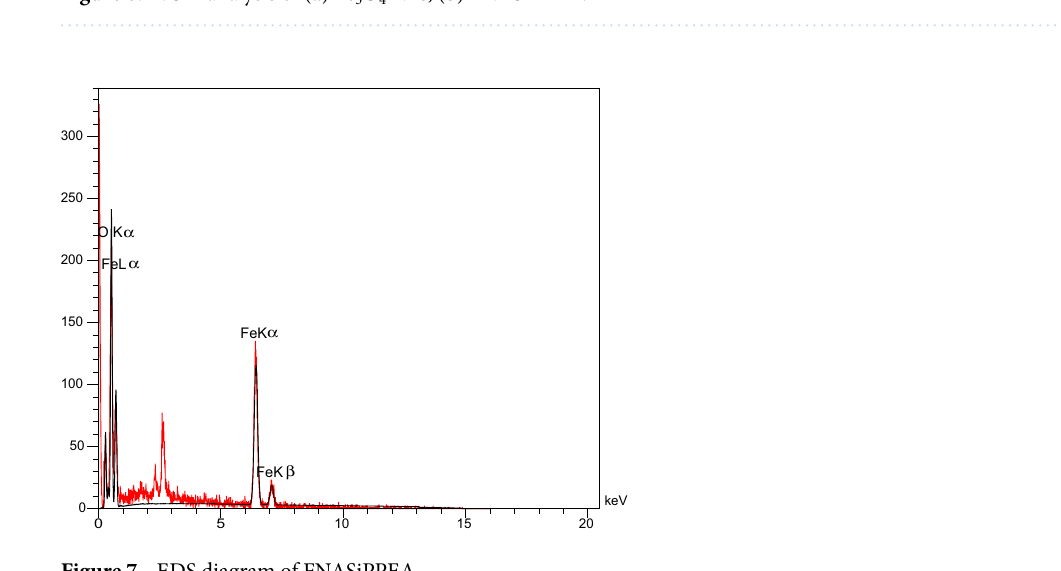
Figure 6. VSM analysis of ( a ) Fe 3 O 4 NPs, ( b ) FNASiPPEA.